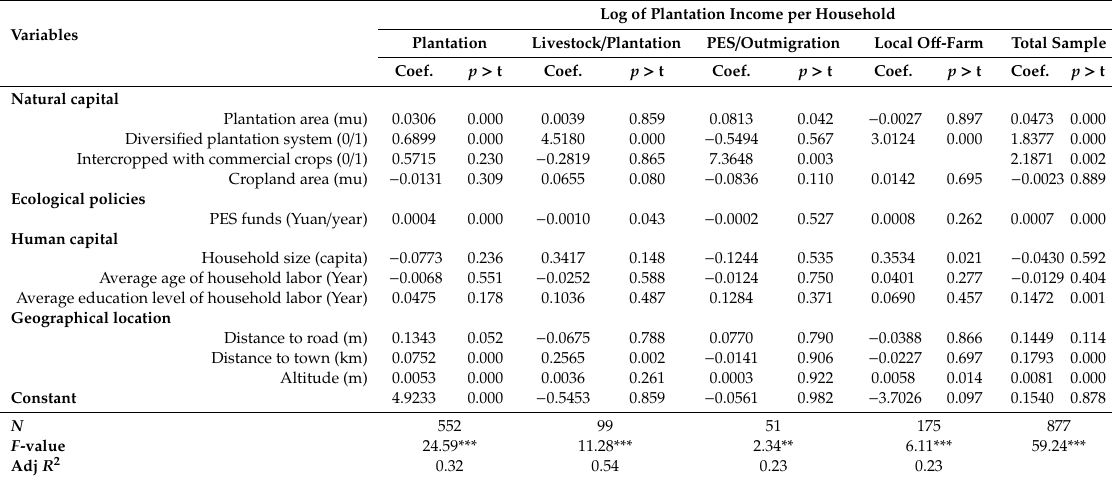
Table 3. Regression relationships between plantation income and forms of capital for di ff erent livelihood strategies. Log of Plantation Income per Household Variables Plantation Livestock / Plantation PES / Outmigration Local O ff -Farm Total Sample Coef. p > t Coef. Coef. Coef. Coef. p > t Natural